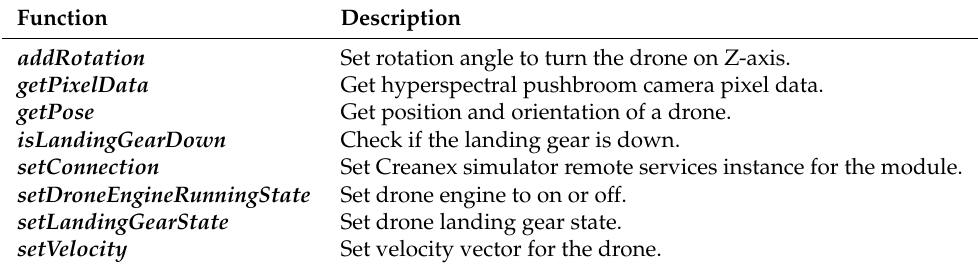
Table 1. Agriculture graphical simulation environment (AgSim) application programming interface (API) drone